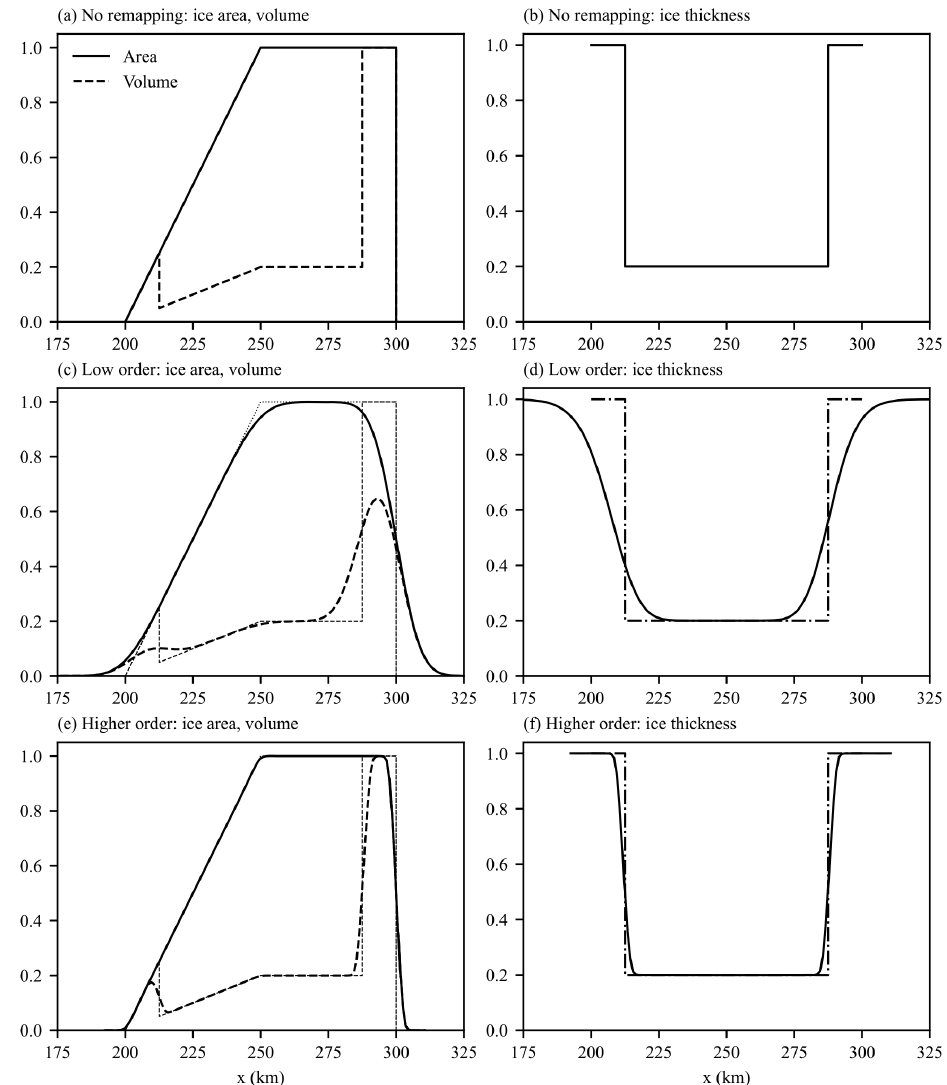
Figure 4. One-dimensional compatibility test case. (a, b) No remapping, (c, d) low-order remapping, (e, f) higher-order remapping. (a, c, e) Ice concentration and volume; (b, d, f) ice